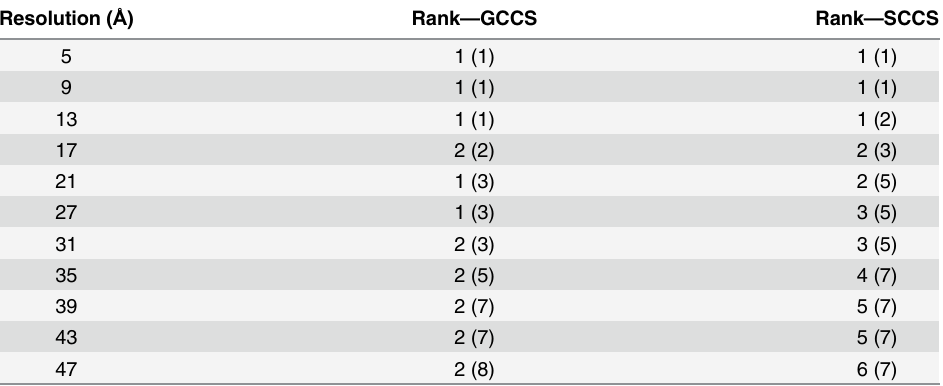
Table 1. Average rank, rounded to the nearest integer, of best RMSD result returned by PF 2 fit — SE(3) in the initial search stage for synthetic maps at different resolutions. The figure in brackets in the second and third columns denotes the rank in the presence of noise at SNR = 1. See the section on “ Datasets ” for a list of PDBs used in this experiment. Note that even if the rank of the best RMSD is lower for SCCS in some cases, the actual RMSDs are generally lower, cf. Figs 5 and